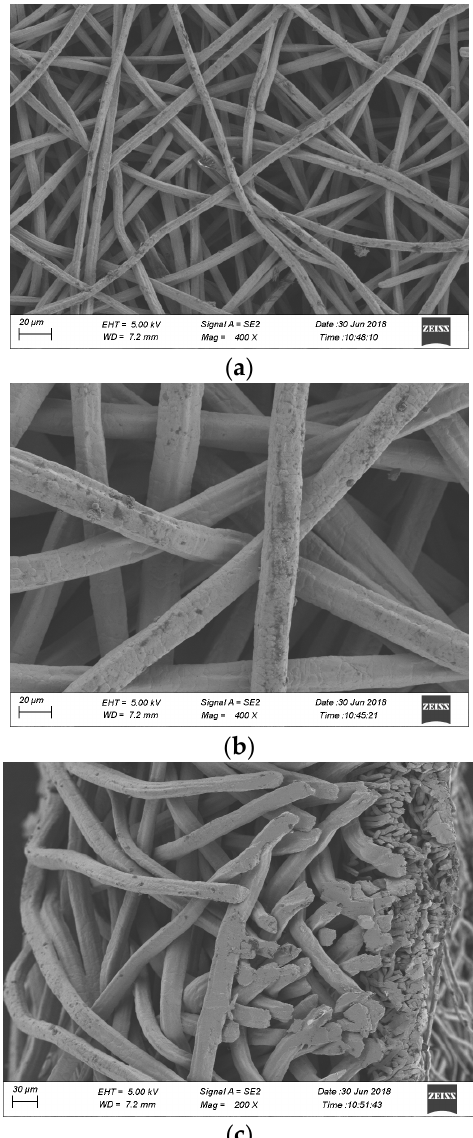
Figure 6. Microstructures of metal filter materials. ( a ) Surface of stainless metal fabric. ( b ) Supporting surface of stainless metal fabric. ( c ) Cross-section of stainless metal fabric.